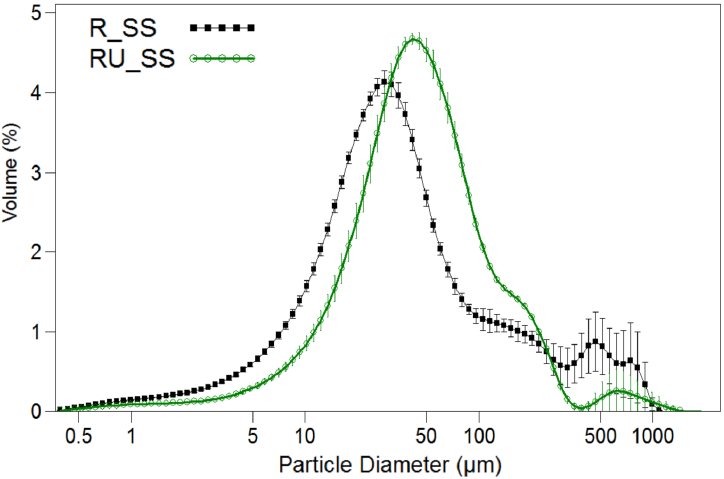
Figure 4. Particle size distribution (PSD) obtained from samples taken from semi-continuous digestion of sewage sludge (R_SS) and ultrasound-pretreated sewage sludge